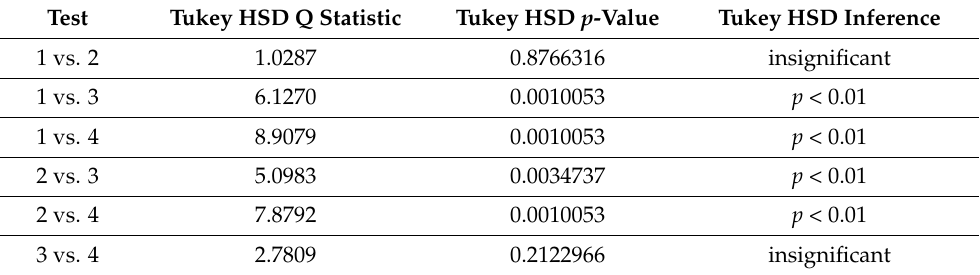
Table 5. Total SSQ score Tukey HSD results.